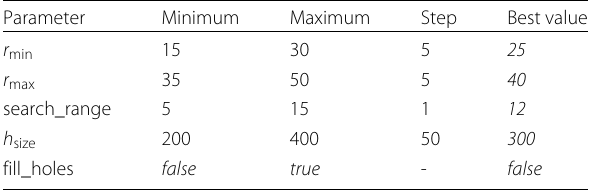
Table 2 Parameter values for the grid search for Zhao et al.’s method